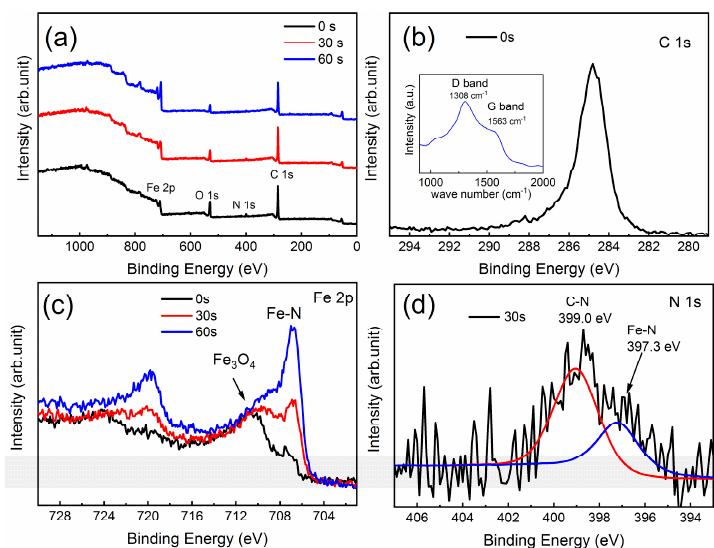
Figure 3. XPS spectra of the α″ -Fe 16 N 2 @C nanocones synthesized at 433 K for six days. ( a ) Survey of the sample with the surfaces cleaned for 0 s, 30 s and 60 s, respectively. ( b ) C 1s, ( c ) Fe 2p and ( d ) N 1s spectra. The inset in ( b ) shows the Raman spectrum of the as-prepared α″ -Fe 16 N 2 @C nanocones.